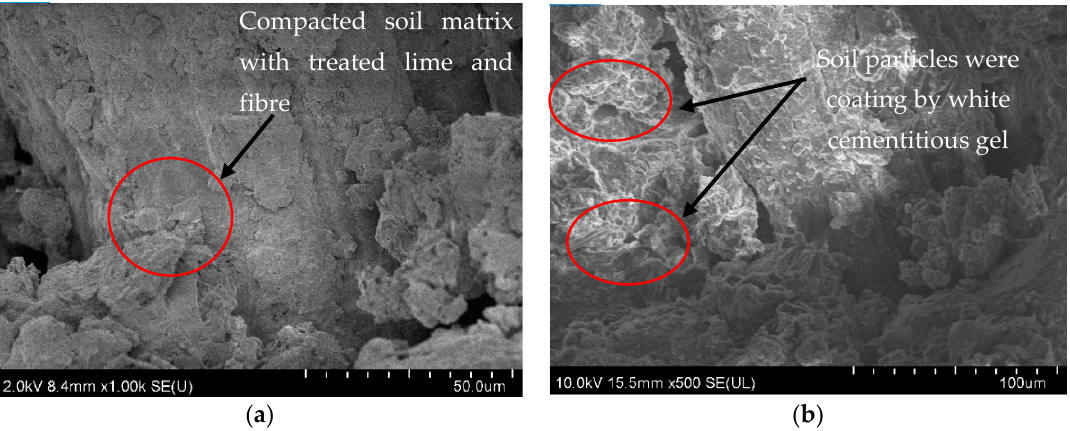
Figure 7. FESEM images for treated soil with inclusion of fibre (CLF). ( a ) Compacted soil matrix with treated lime and fibre, ( b ) Soil particles were coating by white cementitious gel. FESEM images for treated soil with inclusion of fibre (CLF).